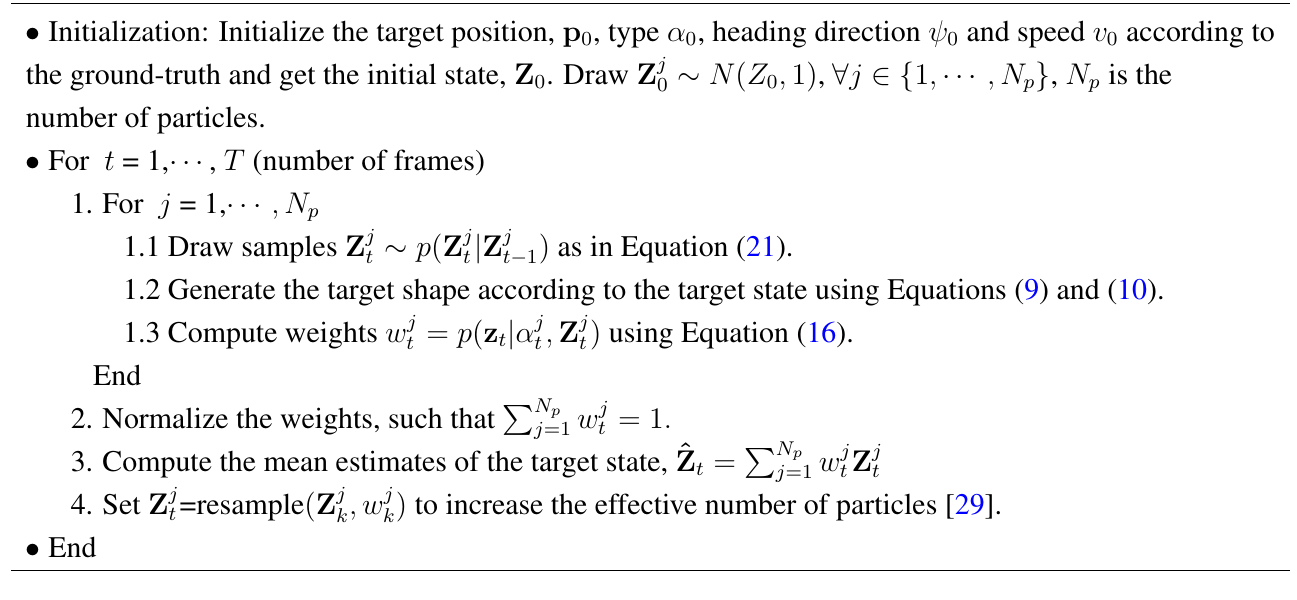
Table 2. Pseudo-code for ATR-Seg